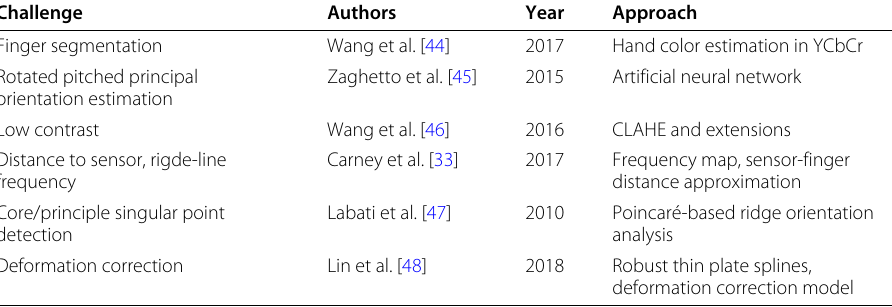
Table 3 Overview of challenges during the preprocessing of finger images and proposed approaches